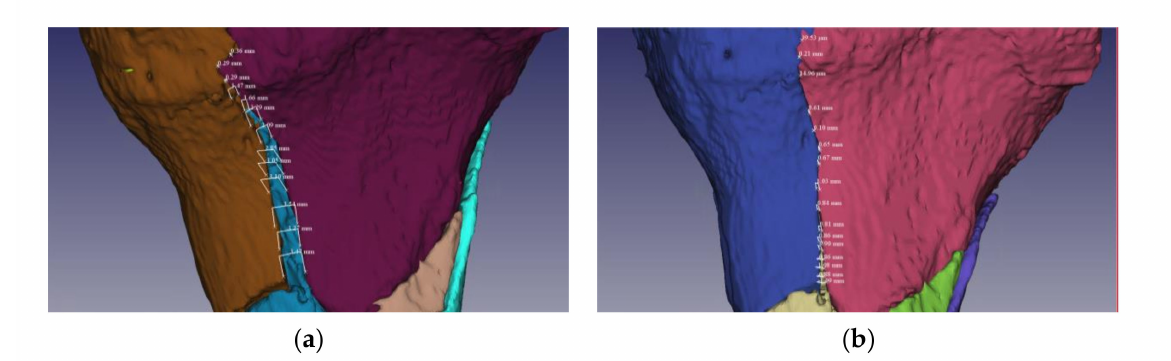
Figure 12. Evaluation of the tibial plateau fracture reduction process by measuring the distances between the fracture fragments and the base bone: ( a ) initial fracture before reduction; ( b ) fracture after reduction supported by the alignment algorithm.